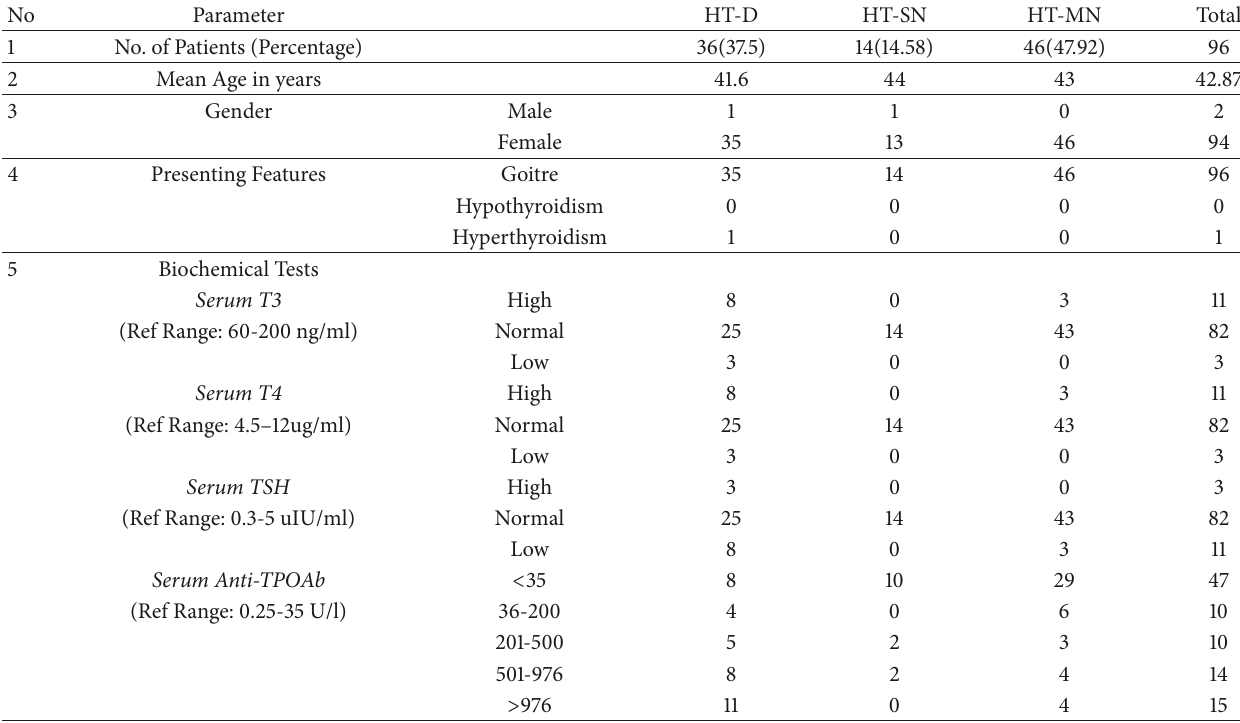
Table 1: Distribution of HT and relation with thyroid hormone status and anti-TPO